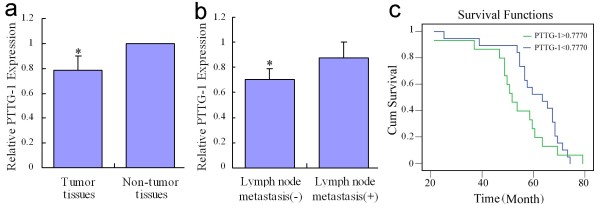
Expression levels of PTTG1 in ESCC tissues and adjacent non-tumor tissues. (a) Compared with adjacent non-tumor tissues, PTTG1 expression levels in ESCC tissues were significantly higher (P < 0.05). (b) Among ESCC tissues, expression levels of PTTG1 in cases with lymph nodes positive for metastases were higher than those in cases with lymph nodes negative for metastases (P < 0.05). (c) Kaplan–Meier curves of the clinical outcome for PTTG1. Primary ESCCs with moderate to strong PTTG1 expression (>0.7770) had significantly worse survival than did those with weak PTTG1 expression (<0.7770) (P < 0.05, log-rank test). T: tumor tissue (n = 34); N: adjacent non-tumor tissue (n = 34). *P < 0.05 compared to the control group.